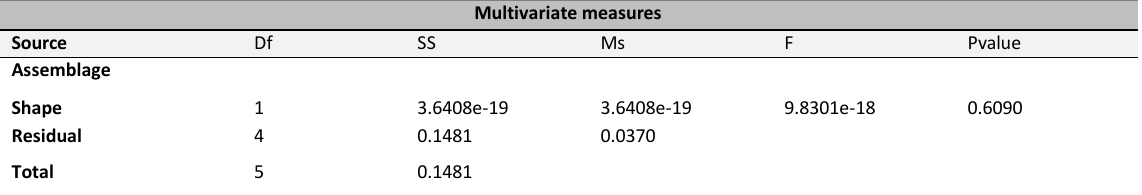
Figure 3: Map showing the five species co-occurence assemblages inventoried on ARs in the 16 sites (AGM1, AGM2, AGD1, AGD2, AGD3, AGD4, AGD5, VLR1, VLR2, GRU1, GRU2, GRU3, LEU1, LEU2, CST1, CST2) in the Gulf of Lion. Table 2: Results of multivariate NP-Manova testing the effect of the shape between steel cage and pipe on the presence/absence assemblage. Sites tested: VLR1 vs VLR2. Significant (P<0.05) values in